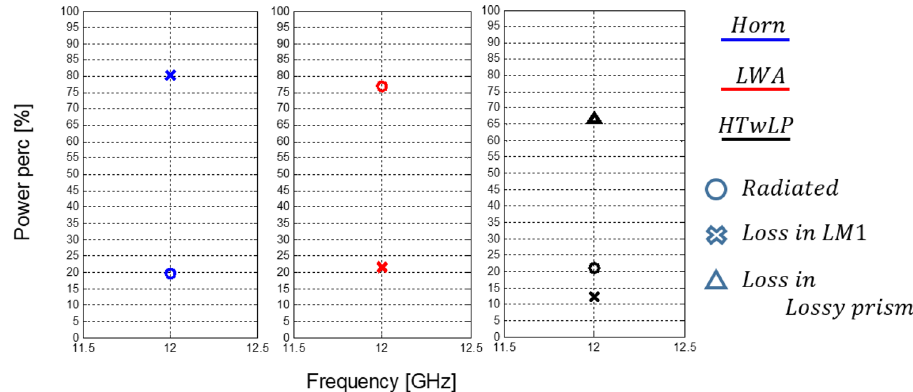
Figure 11. Percentage of power radiated and loss in the three